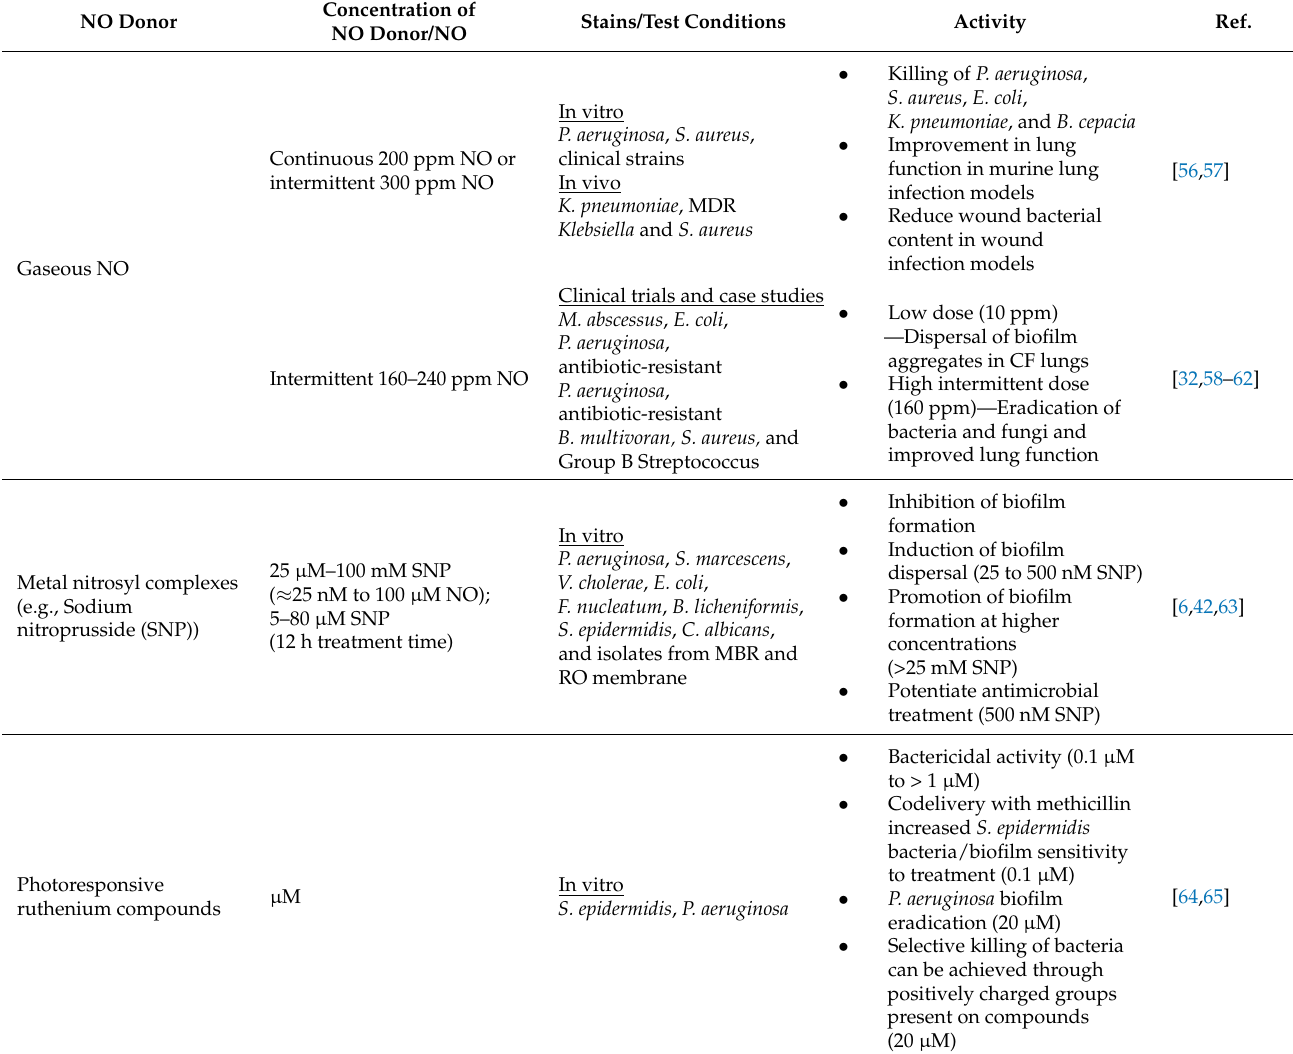
Table 2. Activity of low molecular weight NO donors on planktonic and biofilm bacteria. Concentration of Stains/Test Conditions Activity NO Donor/NO